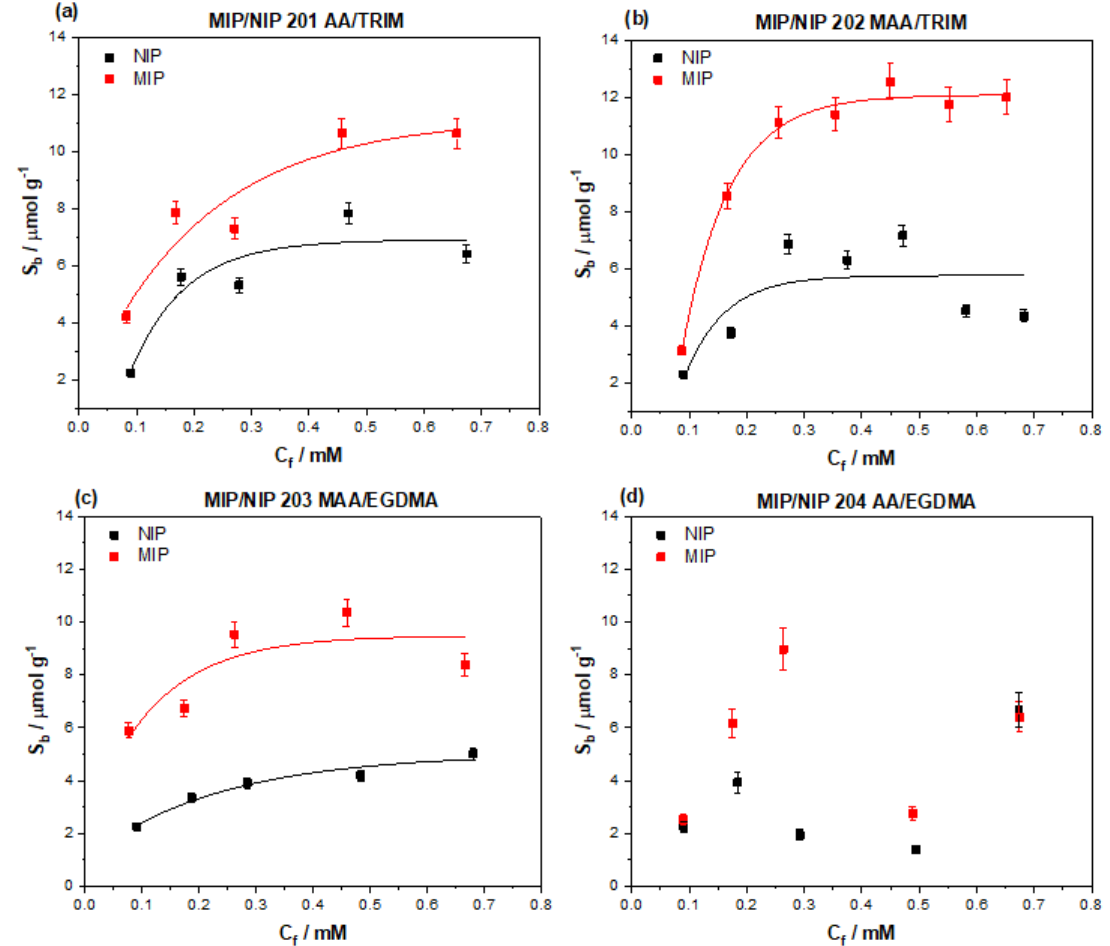
Figure 3. Binding isotherms for the varying MIP compositions ( a ) AA/TRIM, ( b ) MAA/TRIM, ( c ) MAA/EGDMA, and ( d ) AA/EGDMA synthesized by monolithic free radical polymerization. Table 2. Binding capacities (S b ) for MIP 201, 202, 203, and 204 at C f = 0.1, 0.2, and 0.3 mM, and their corresponding imprint factors (IF). Values were drawn directly from the fitted curve of each MIP/NIP at the defined concentration. MIP/NIP